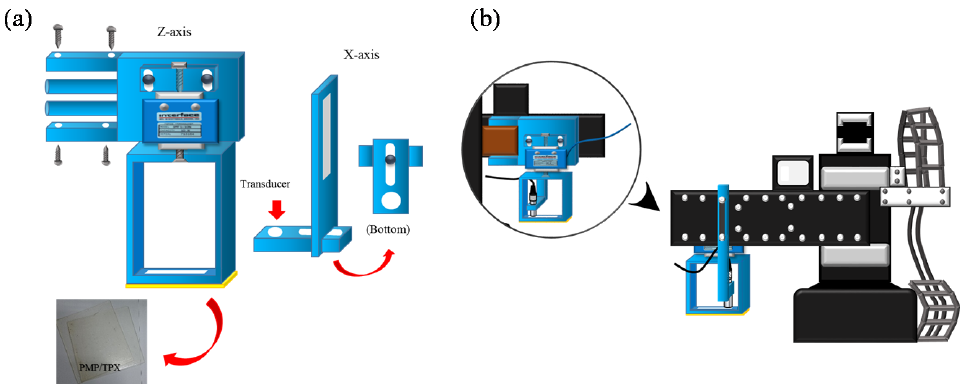
Figure 2. ( a ) Load cell and compression plate and ( b ) indentation system.